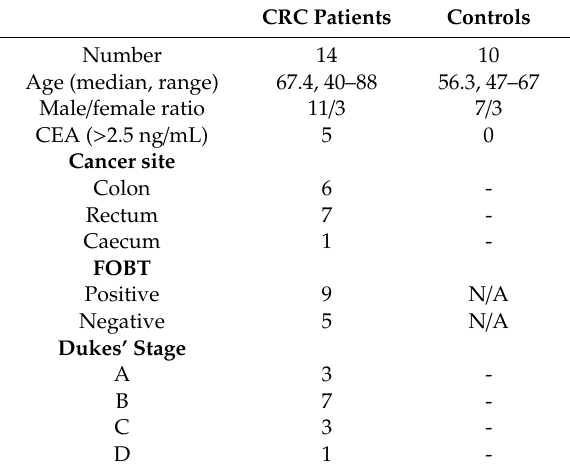
Table 1. Characteristics of the study